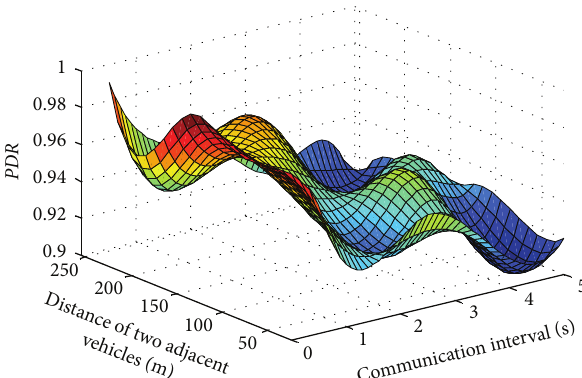
Figure 9: The PDR of using repetition model decision algorithm (number 7).